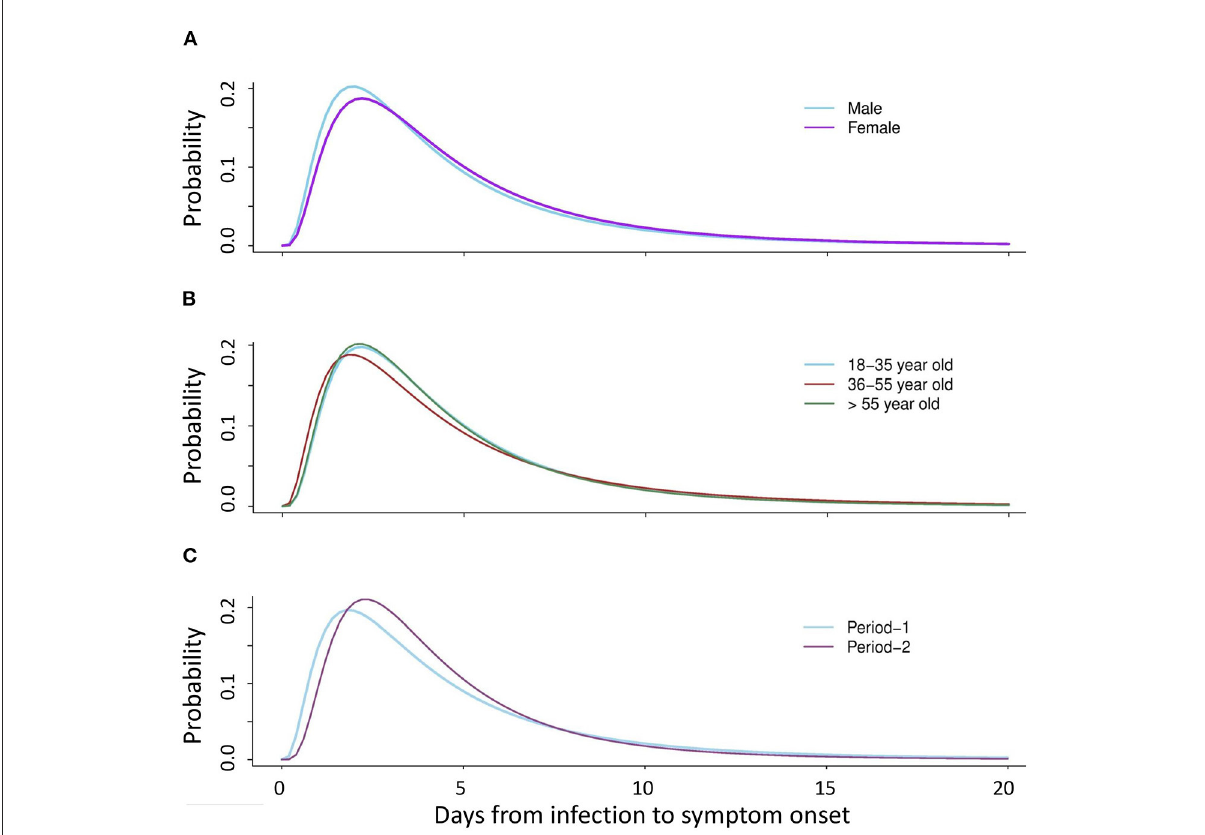
FIGURE1 Distribution of the COVID-19 incubation period after stratification by gender, age group, and epidemic period (Period-1: 19 January 2020 and Period-2: 20 April 16 October 2020) for the confirmed cases using the log-normal distribution model. (A) Estimated median − incubation period after stratification by gender: male (median: 4.9 days); female (median: 4.6 days). (B) Estimated median incubation period after stratification by age: young adults (median: 4.8 days), middle-aged adults (median: 5.0 days), older adults (median: 4.3 days). (C) Estimated median incubation period after stratification by epidemic period: Period-1 (median: 4.8 days), and Period-2 (median: 4.4